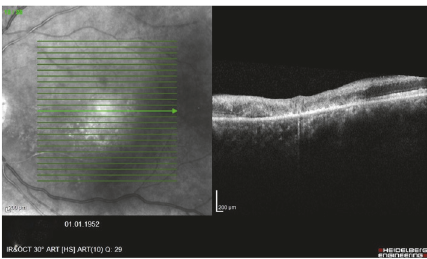
Figure 5: After 1 month of macular